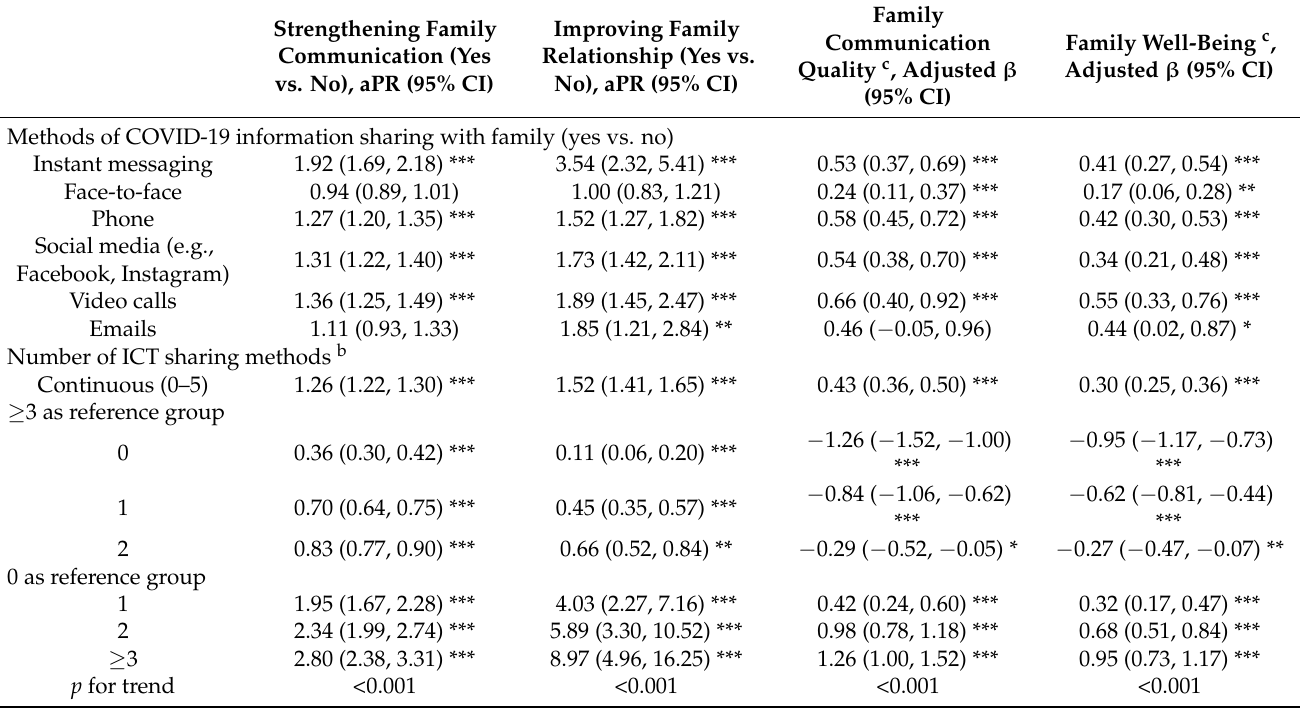
Table 3. Associations of COVID-19 information sharing methods with perceived benefits of ICT and family communication quality and well-being a